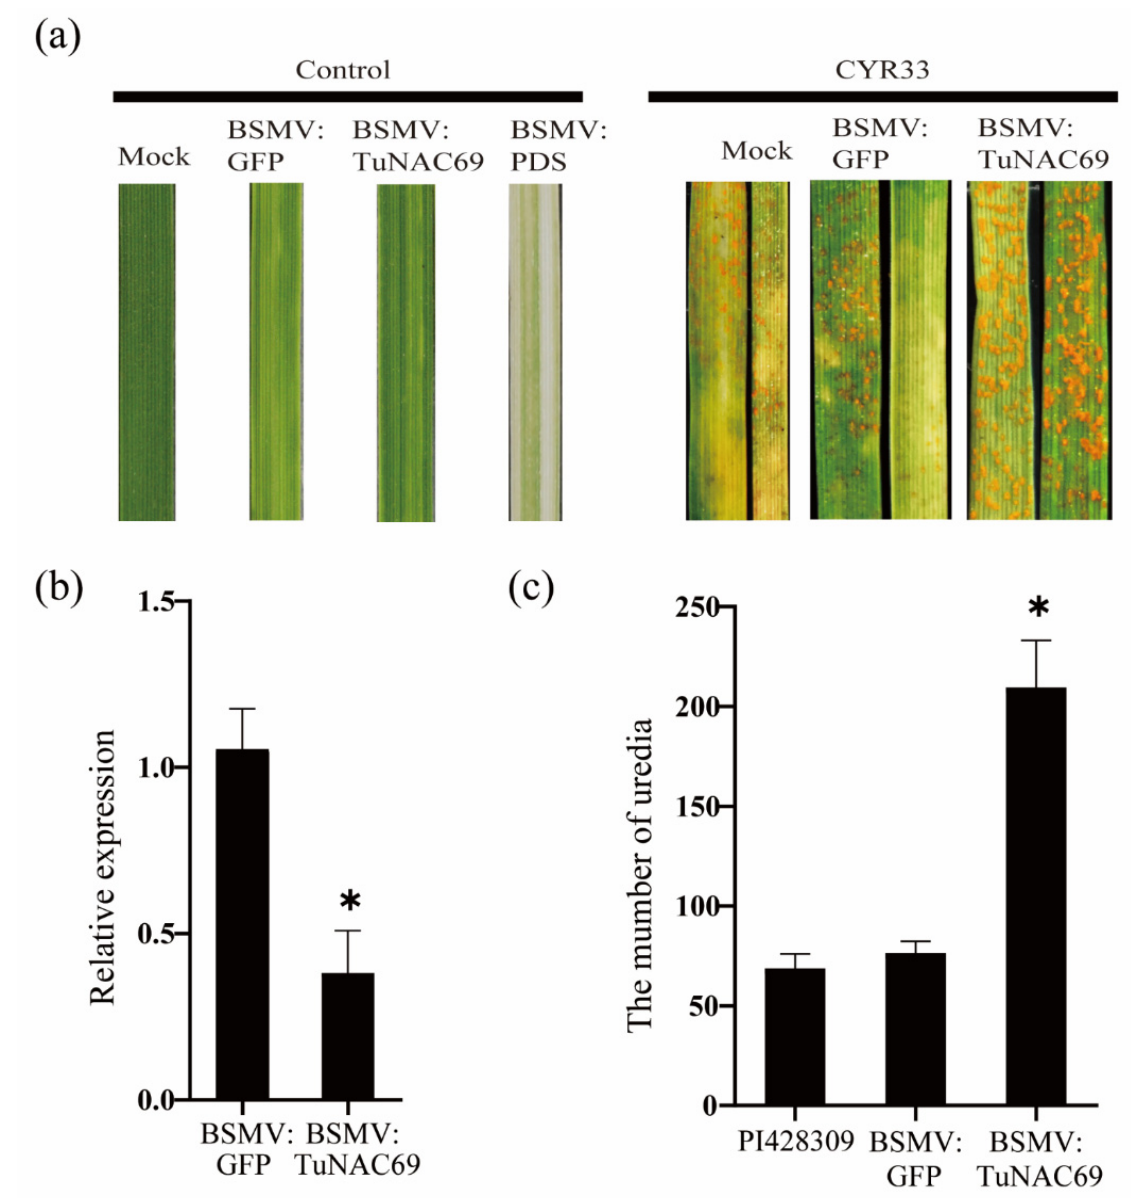
Figure 5. Barley stripe mosaic virus (BSMV) ‐ induced silencing of TuNAC69 compromised the re ‐ sistance of PI428309 to Pst CYR33. ( a ) PI428309 was inoculated with the BSMV on the second leaf. Inoculated with urediniospores of Pst CYR33 on the fourth leaf after 21 days. Leaves infected with Pst CYR33 were examined at 14 dpi. ( b ) The transcript levels of TuNAC69 were examined by quantitative reverse transcription PCR (qRT ‐ PCR). TuACTIN was used as an internal control. ( c ) The number of uredia per cm 2 on wheat leaves. Error bars represent ± SD of values obtained from at least three independent biological samples. Statistically significant difference (Student’s t ‐ test): *, p < 0.05.